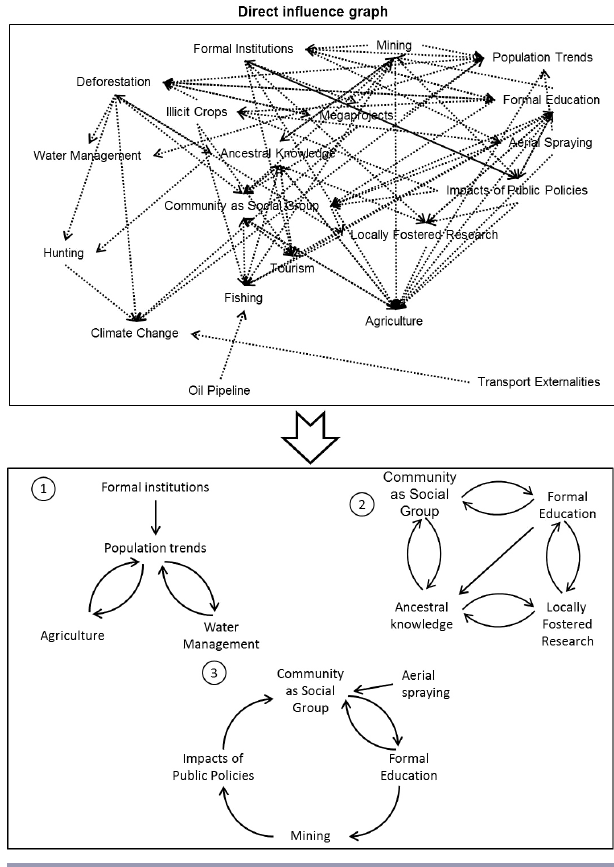
Fig. 11 . Influence graph provided by MICMAC (top graph) and reinforcement cycles extracted using VENSIM (bottom graph) in